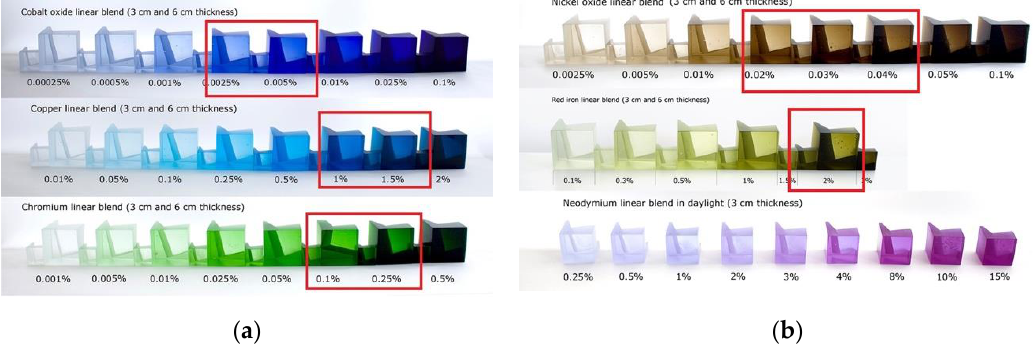
Figure 8. Heike Brachlow, Line blends, cast glass, with tipping point highlighted. Photographs by Ester Segarra, courtesy of the artist. ( a ) Cobalt oxide: 0.00025–0.01%; copper oxide: 0.01–2%; chromium oxide: 0.01–0.5%. ( b ) Nickel oxide: 0.0025–0.1%; red iron oxide Fe 2 O 3 : 0.1–3%; and neodymium oxide (3 cm): 0.25 – 15%.